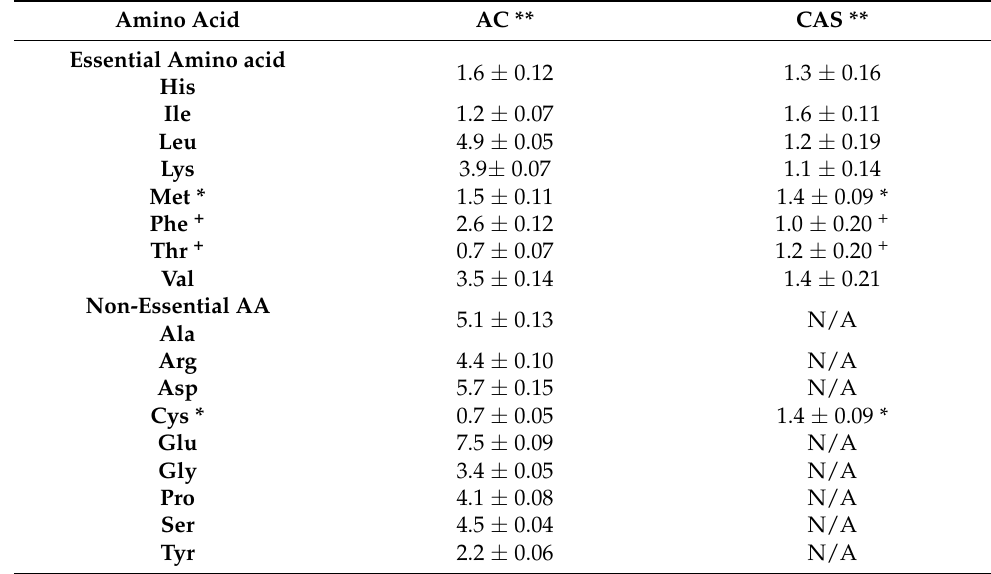
Table 2. Amino acid (AA) composition and essential amino acid scores of cricket